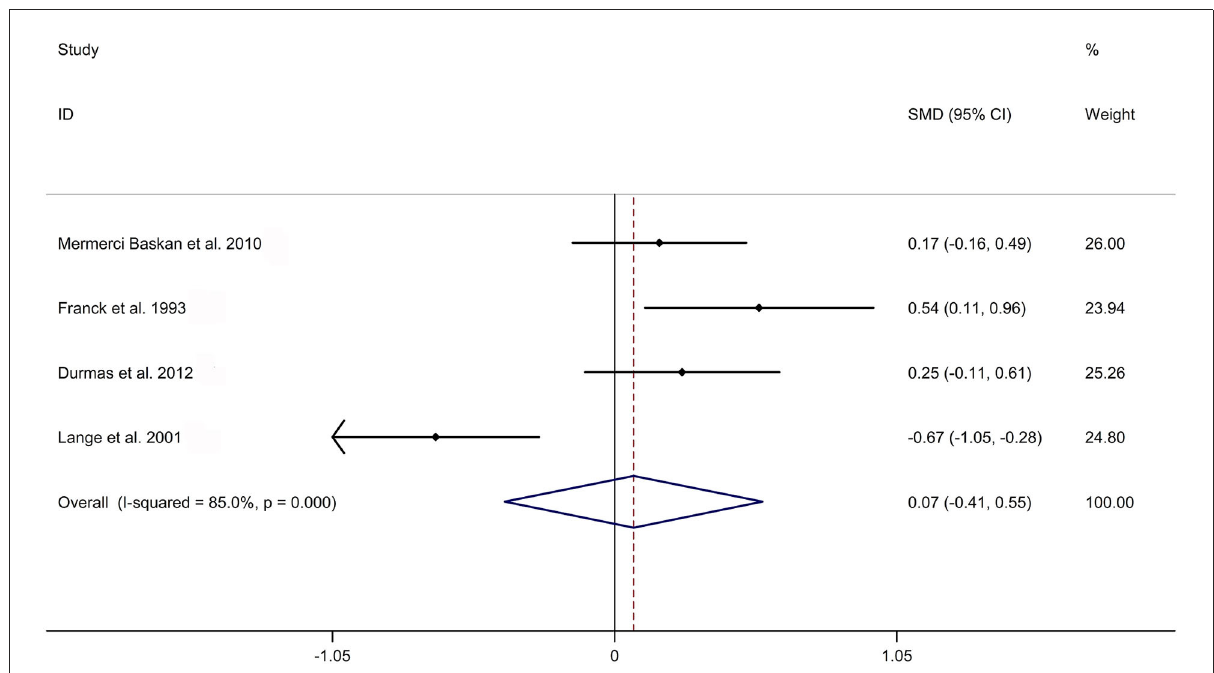
FIGURE3 Forest plot regarding comparison in peripheral ALP levels between AS and HC. ALP, alkaline phosphatase; AS, ankylosing spondylitis; HC, healthy controls.